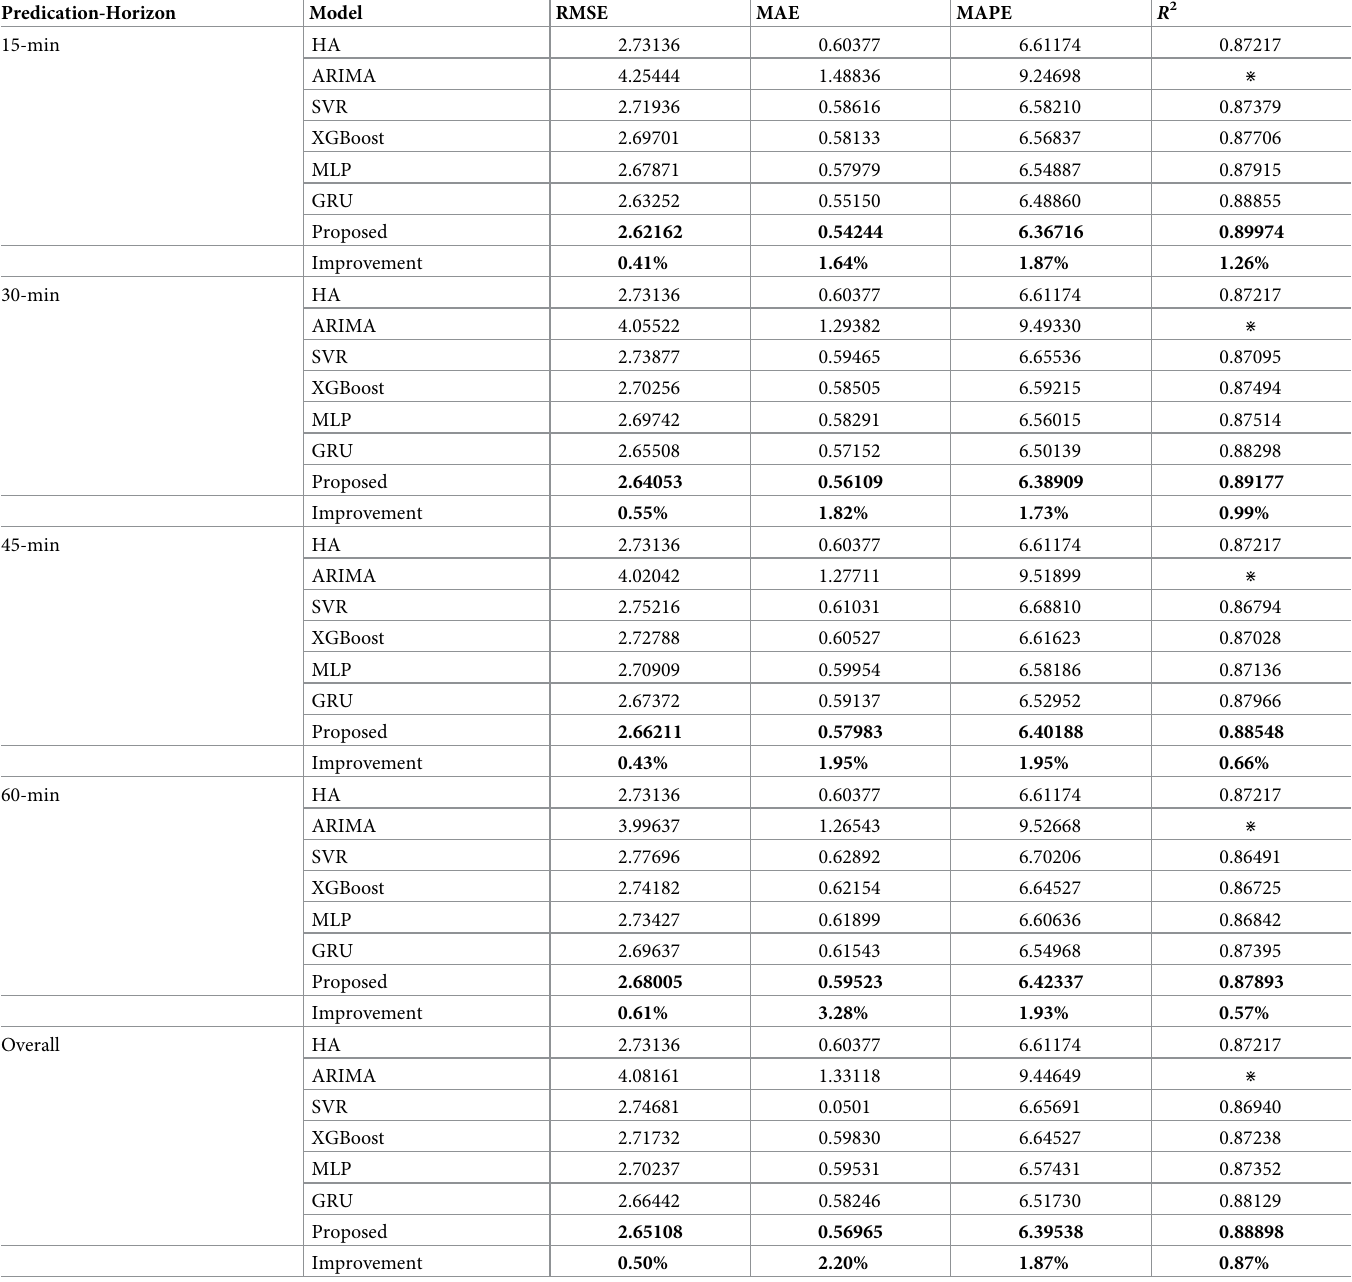
Table 1. Performance evaluation of baselines & proposed